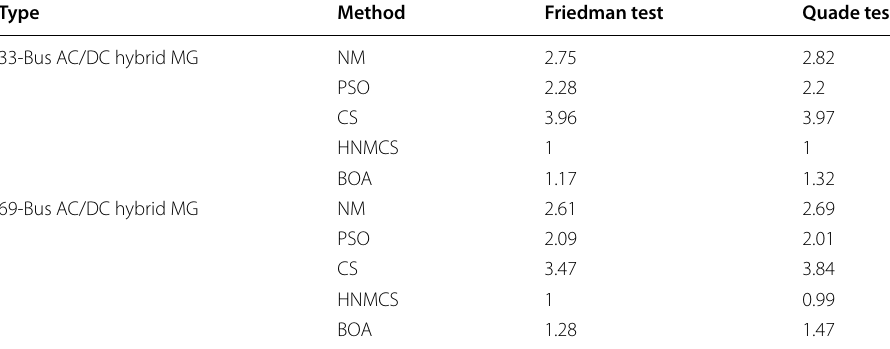
Table 8 Statistical analysis of